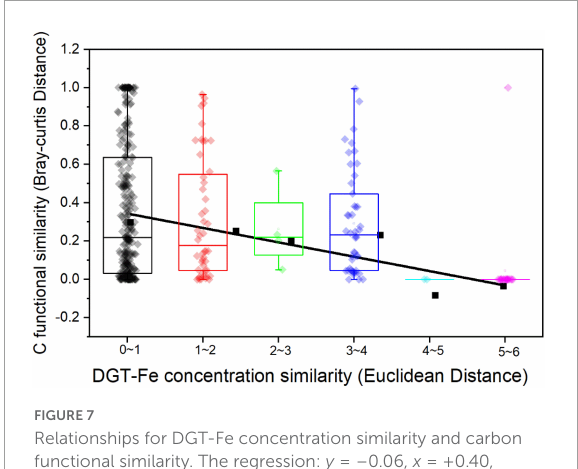
FIGURE7 Relationships for DGT-Fe concentration similarity and carbon functional similarity. The regression: y = –0.06, x = +0.40, r 2 = 0.65, p <